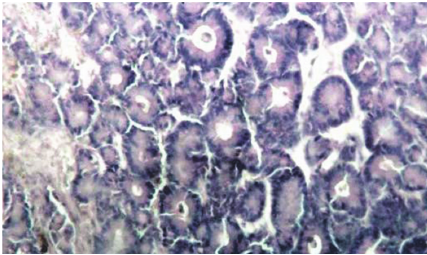
Figure 2: The histopathological appearance of the tumor in the pancreas. Hematoxylin-eosin original magnification ×